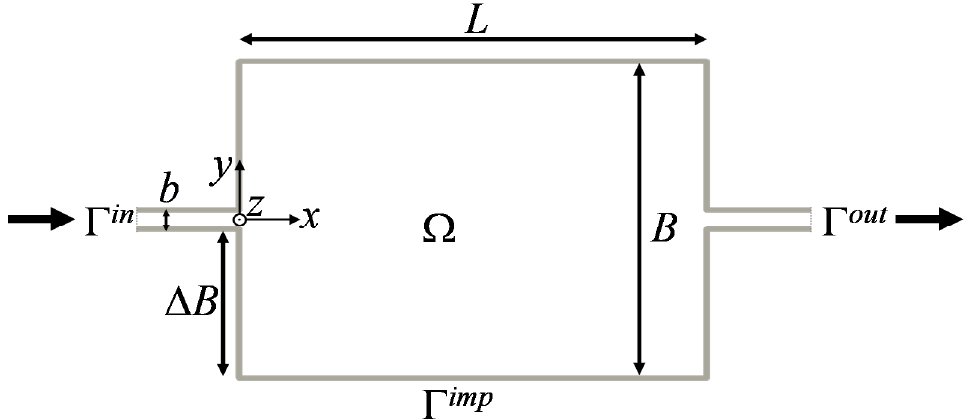
Figure 1. Geometry of the rectangular shallow reservoirs and main notations. Ω is the domain of interest, while Γ in , Γ out and Γ imp refer to the inlet, outlet and impermeable boundaries, respectively.